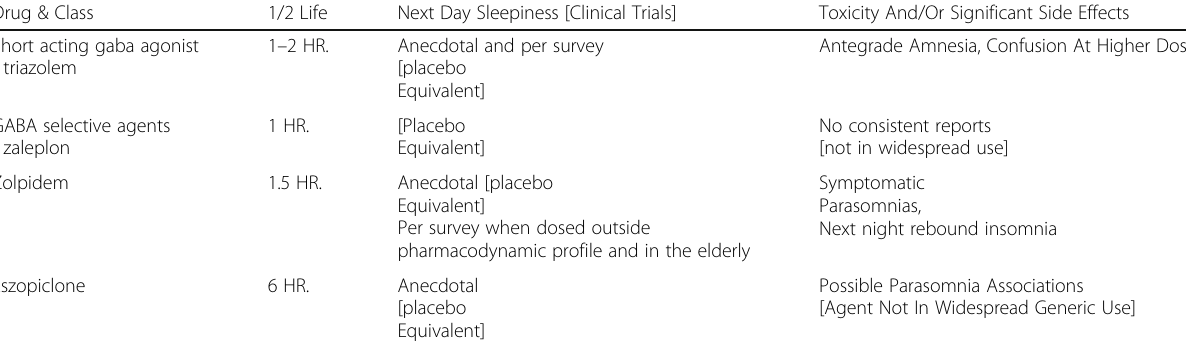
Table 3 Hypnotics - Agents Utilized To Induce Sleep With Minimal Next Day Sleepiness After Used Based On Pharmacodynamics, Clinical Trials, And/Or Performance Testing Drug & Class 1/2 Life Next Day Sleepiness [Clinical Trials] Short acting gaba agonist -